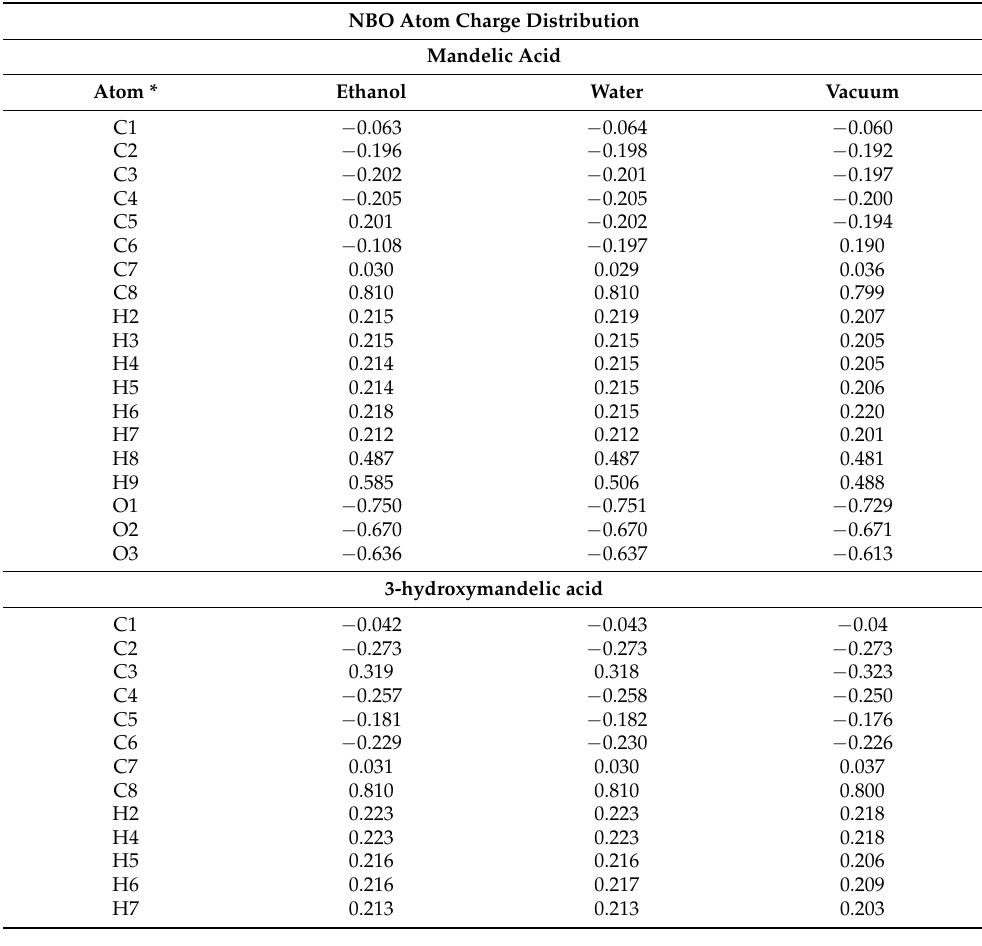
Table 5. NBO Atom Charge Distribution for mandelic acid and its hydroxy end methoxy